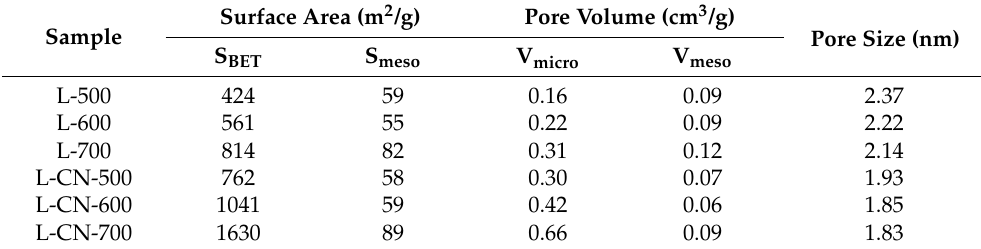
Figure 2. N 2 sorption isotherms ( a , b ), and pore size distribution curves ( c , d ) of lignite-based porous carbons. Table 1. Textural properties of lignite-based porous carbons prepared at different activation temperatures.